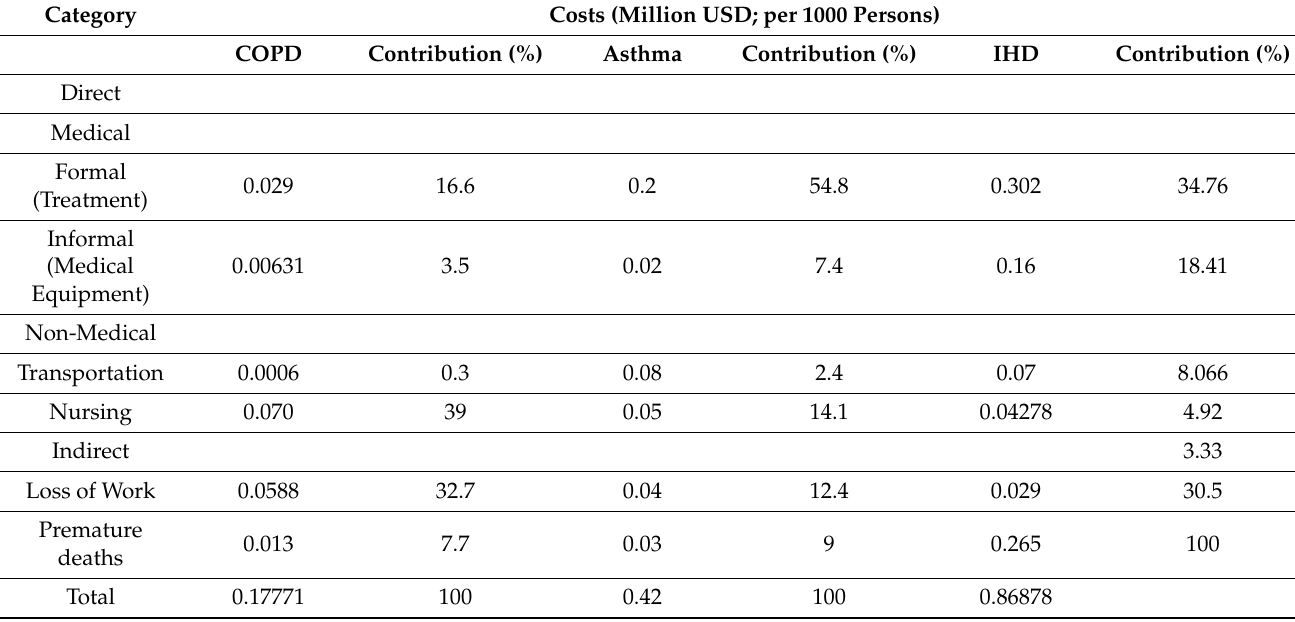
Table 6. Economic loss due to COPD, asthma, and